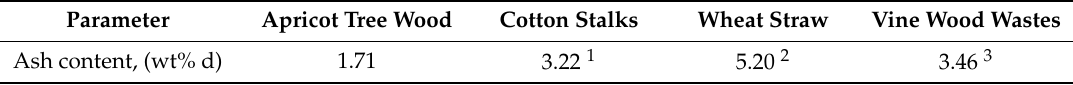
Table 1. Content of tested residual apricot biomass in comparison with other selected materials. Parameter Apricot Tree Wood Cotton Stalks Wheat Straw Vine Wood Wastes